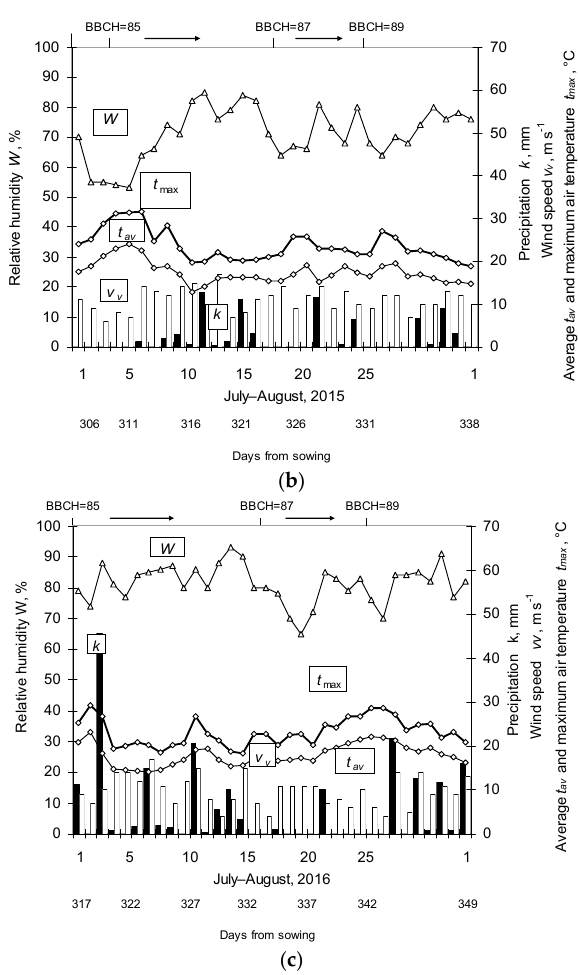
Figure 3. Weather conditions in 2014 ( a ), 2015 ( b ), and 2016 ( c ). Table 2. E ff ect of pod sealant on moisture content (mean ± 95% confidence level) of pod valves ( q ) and seeds ( w ) and the force ( F ) necessary for pod opening at harvest in 2014, 2015, and 2016. Values with similar letters were not significantly di ff erent at p < 0.05 significance